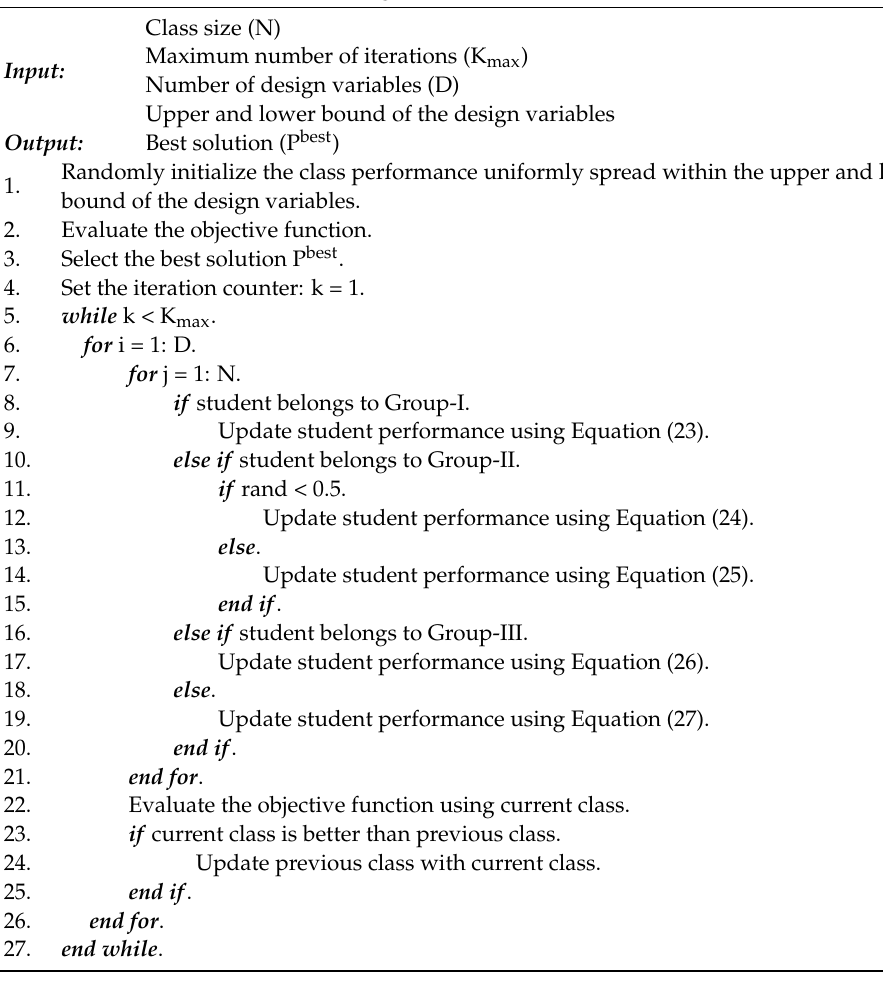
Algorithm 1. Pseudocode for SPBO